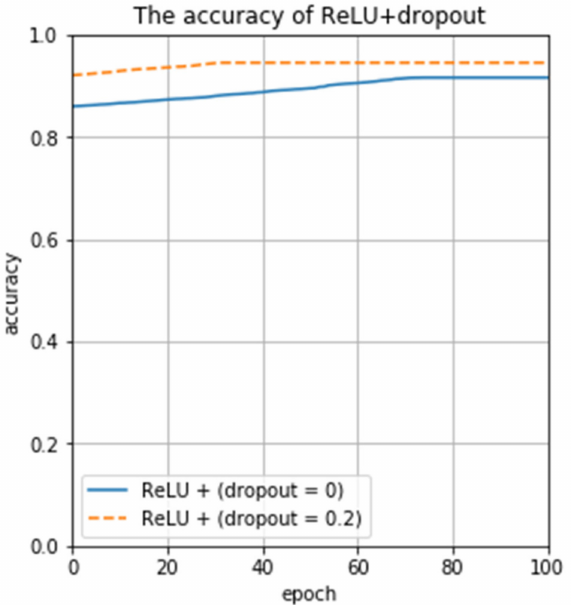
Figure 11. The impact of the dropout value on the recognition